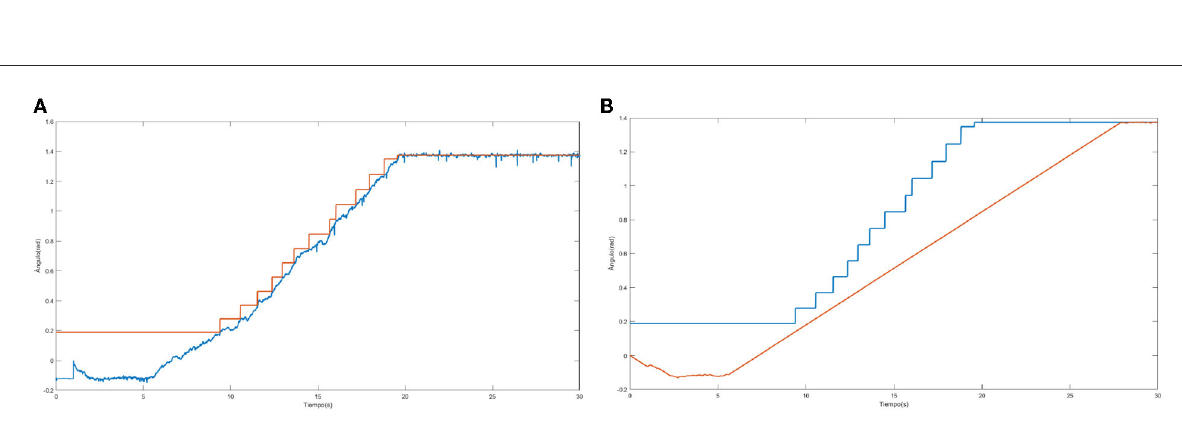
FIGURE13 (A,B) Learning path for ground tilt and desired and actual motion path for ground